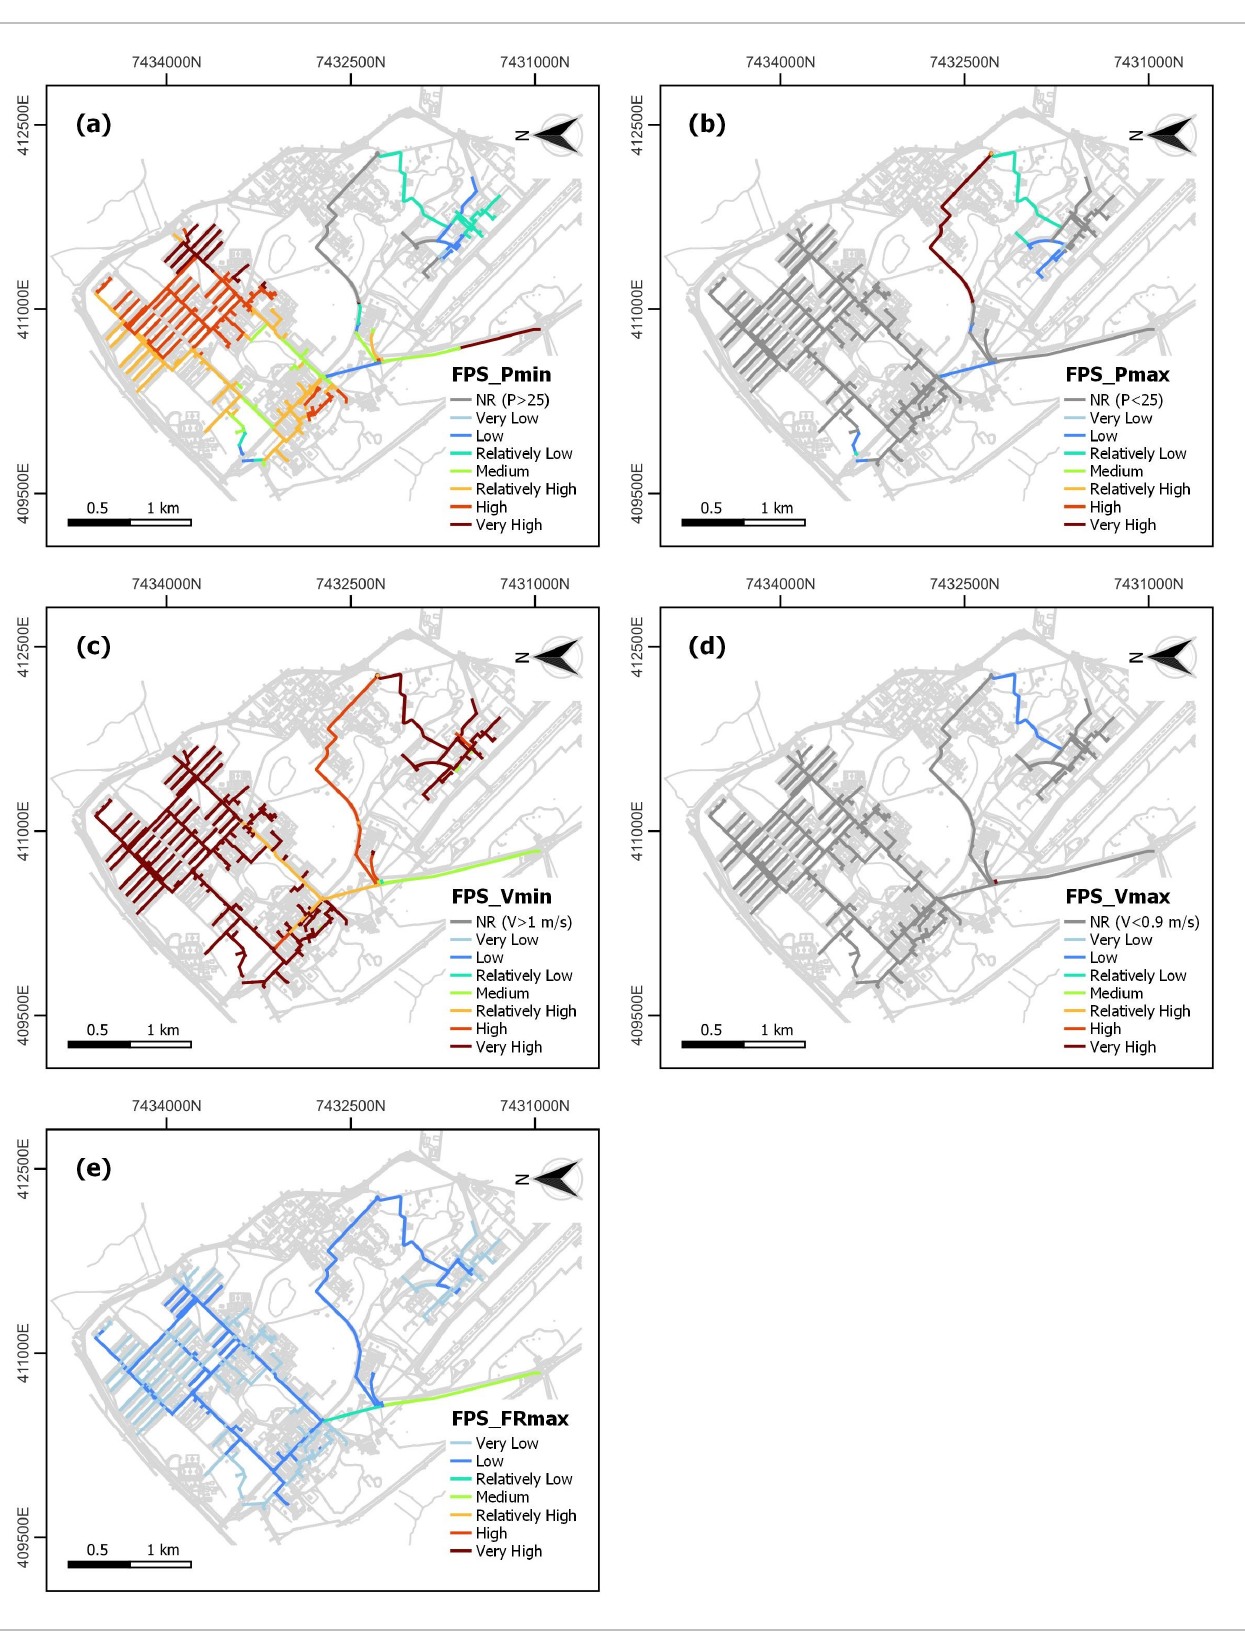
Figure 2. Risk level associated with hydraulic failure in pipes: ( a ) minimum pressure; ( b ) maximum pressure; ( c ) minimum velocity; ( d ) maximum velocity; and ( e ) maximum fl ow.